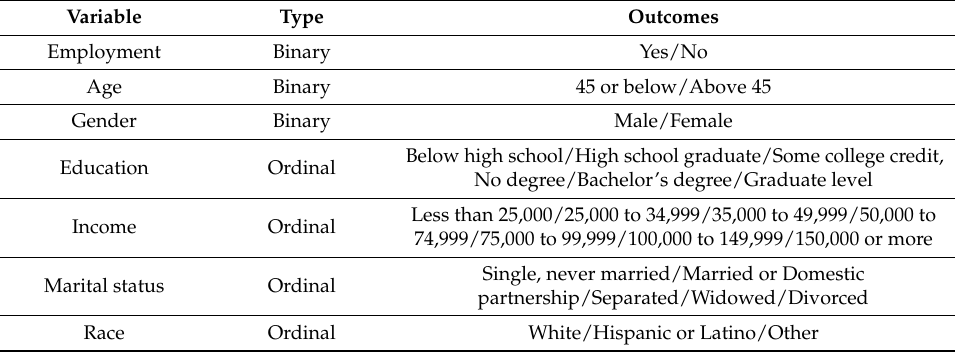
Table 5. Target variables and their